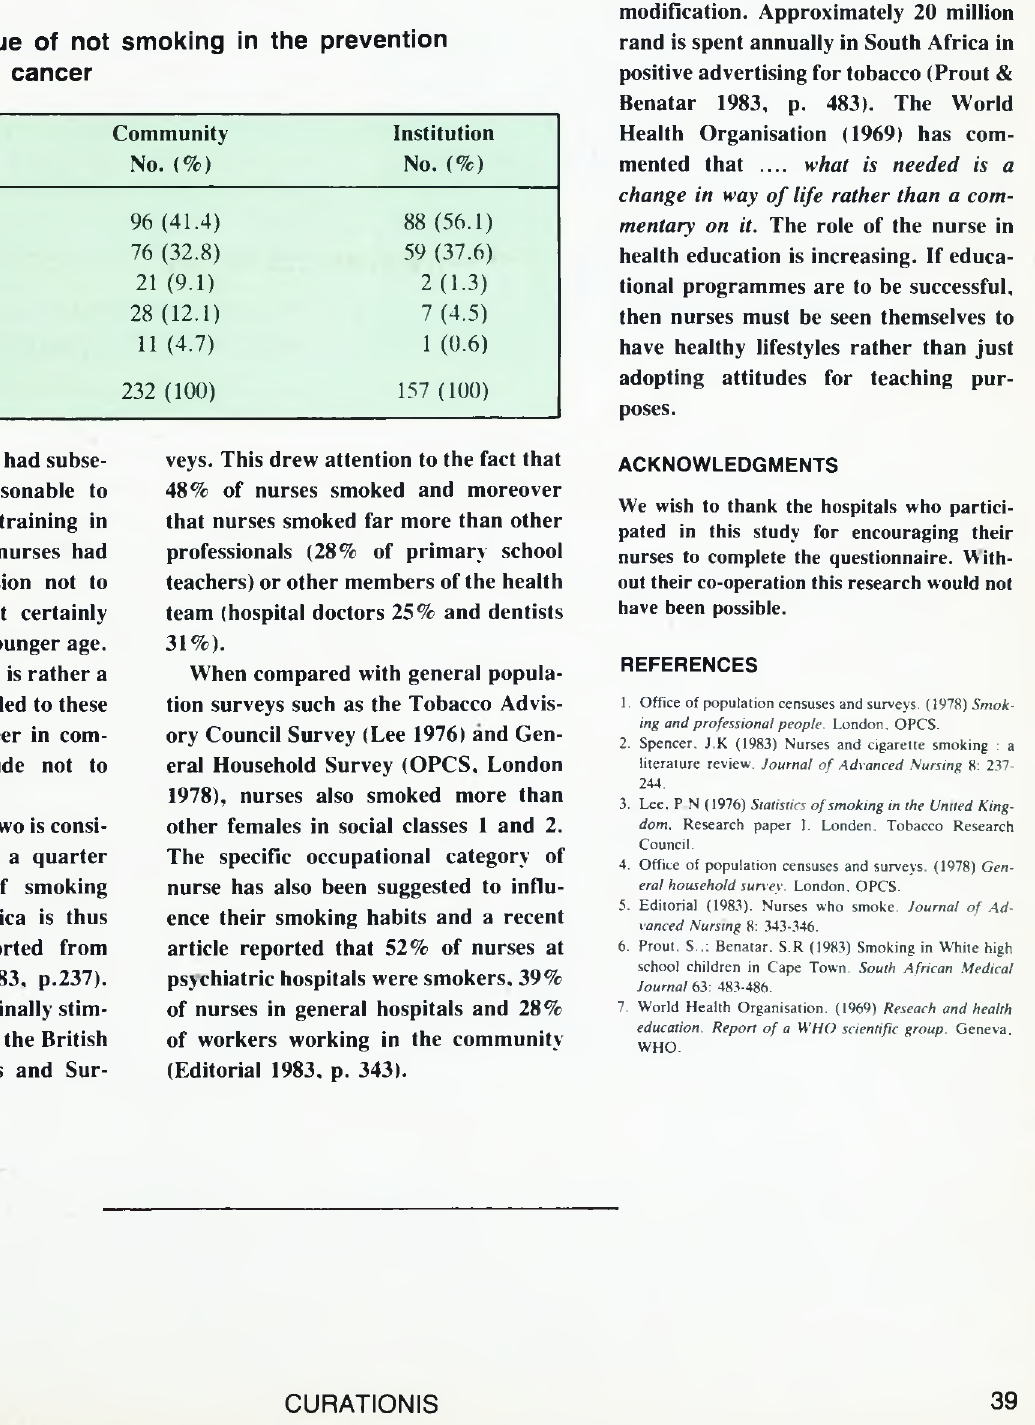
Table 5 — The Value of not smoking in the